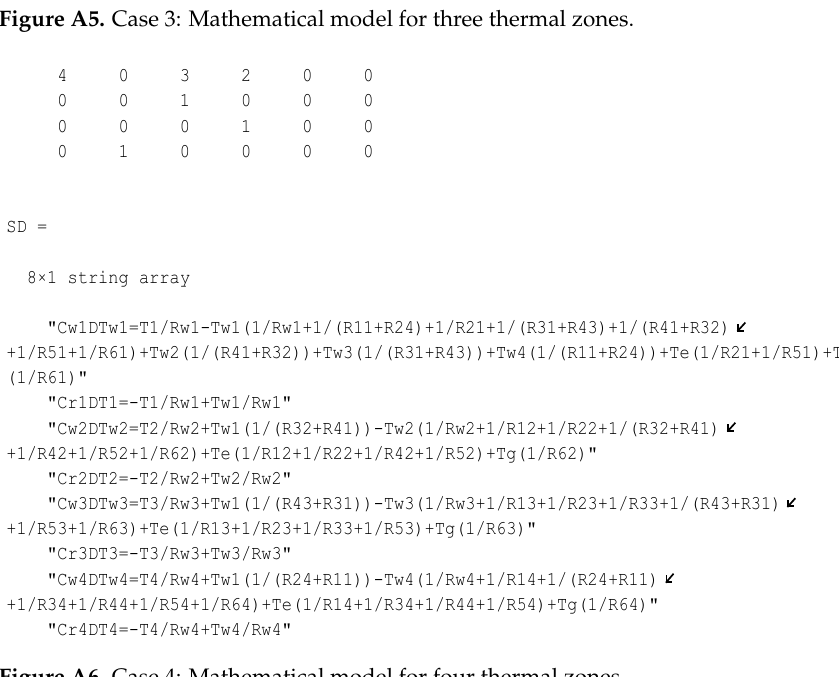
>> Figure A6. Case 4: Mathematical model for four thermal